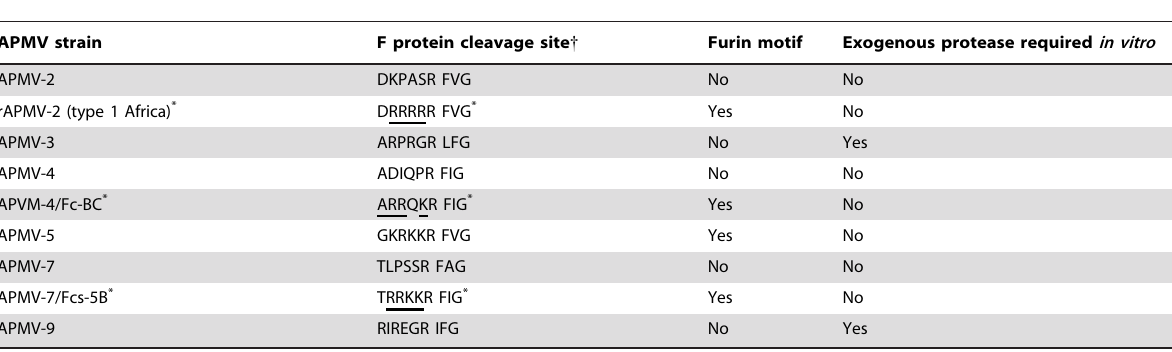
Table 1. APMV strains, F protein cleavage sites, and protease